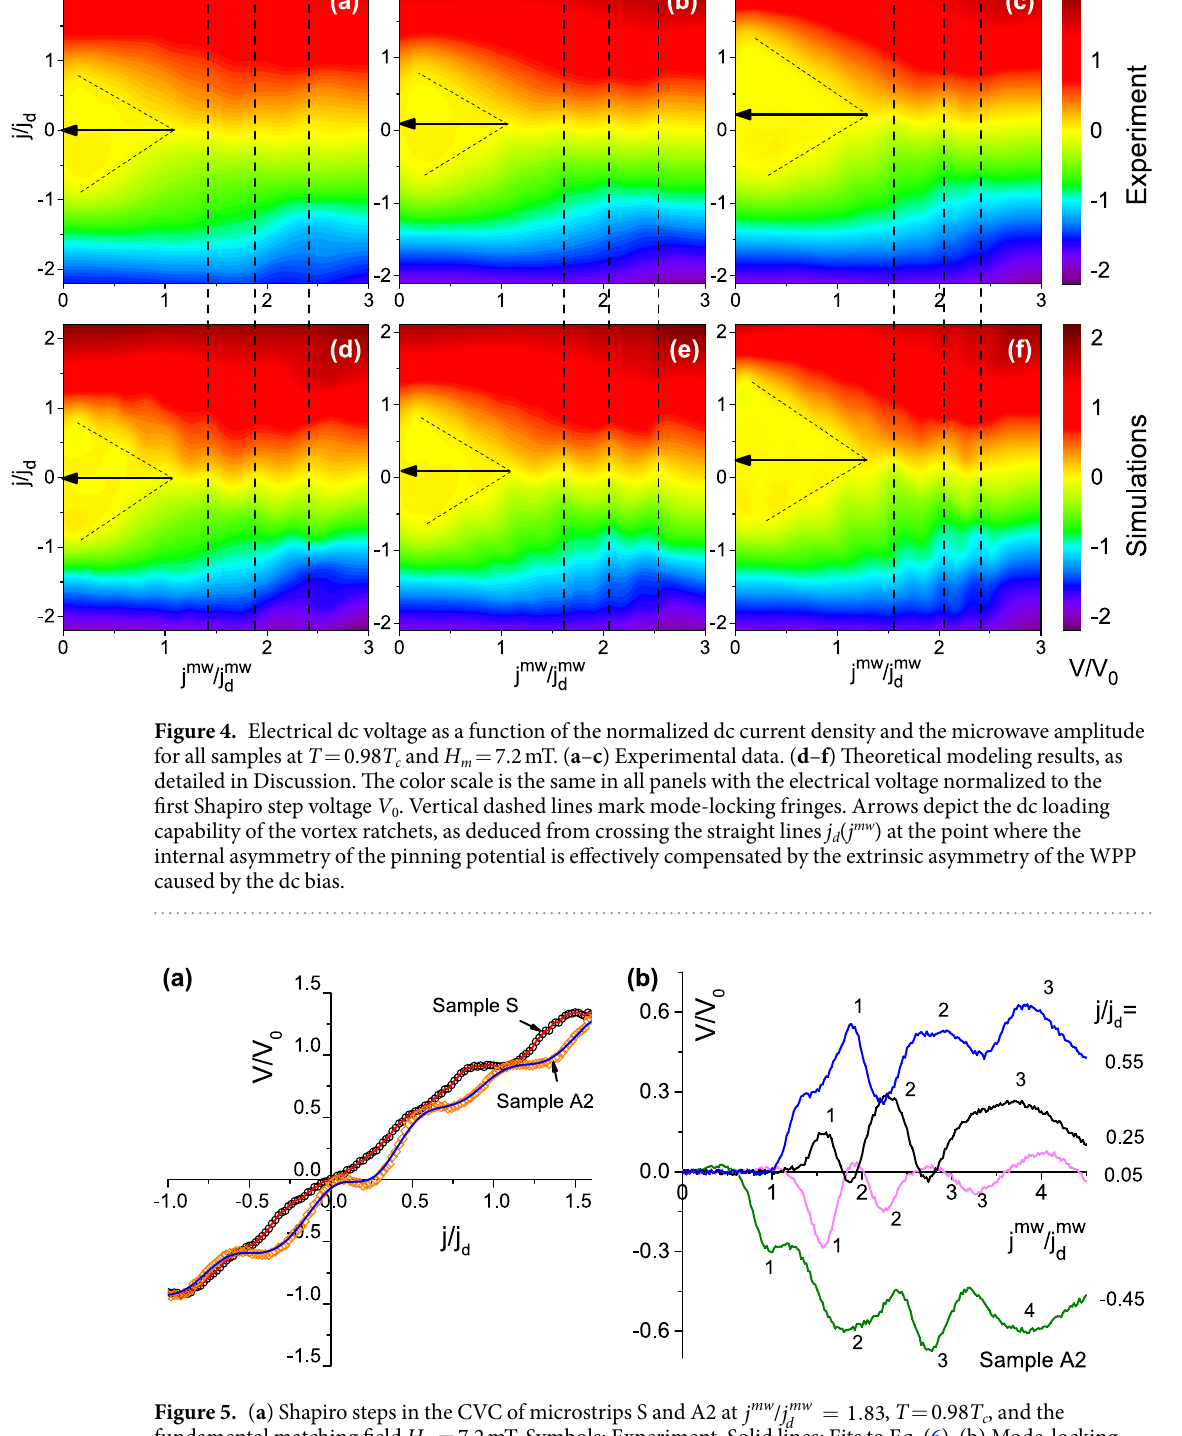
absorption at T = 0.3 T c we employ a stochastic model of uniaxial periodic pinning 37,38,40 to fit the peculiarities observed in electrical voltage responses at noticeably higher temperatures T = 0.98 T c . The theoretical treatment relies upon the Langevin equation for a vortex moving with velocity v in a magnetic field B = z B , where B ≡ | B |, and z is the unit vector in the z direction